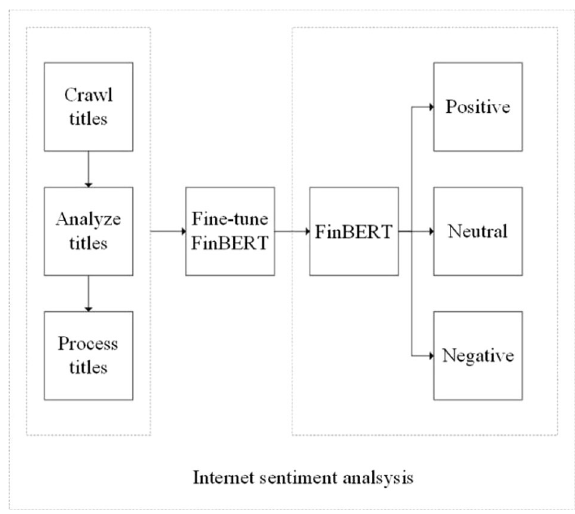
Fig. 1 Process of sentiment